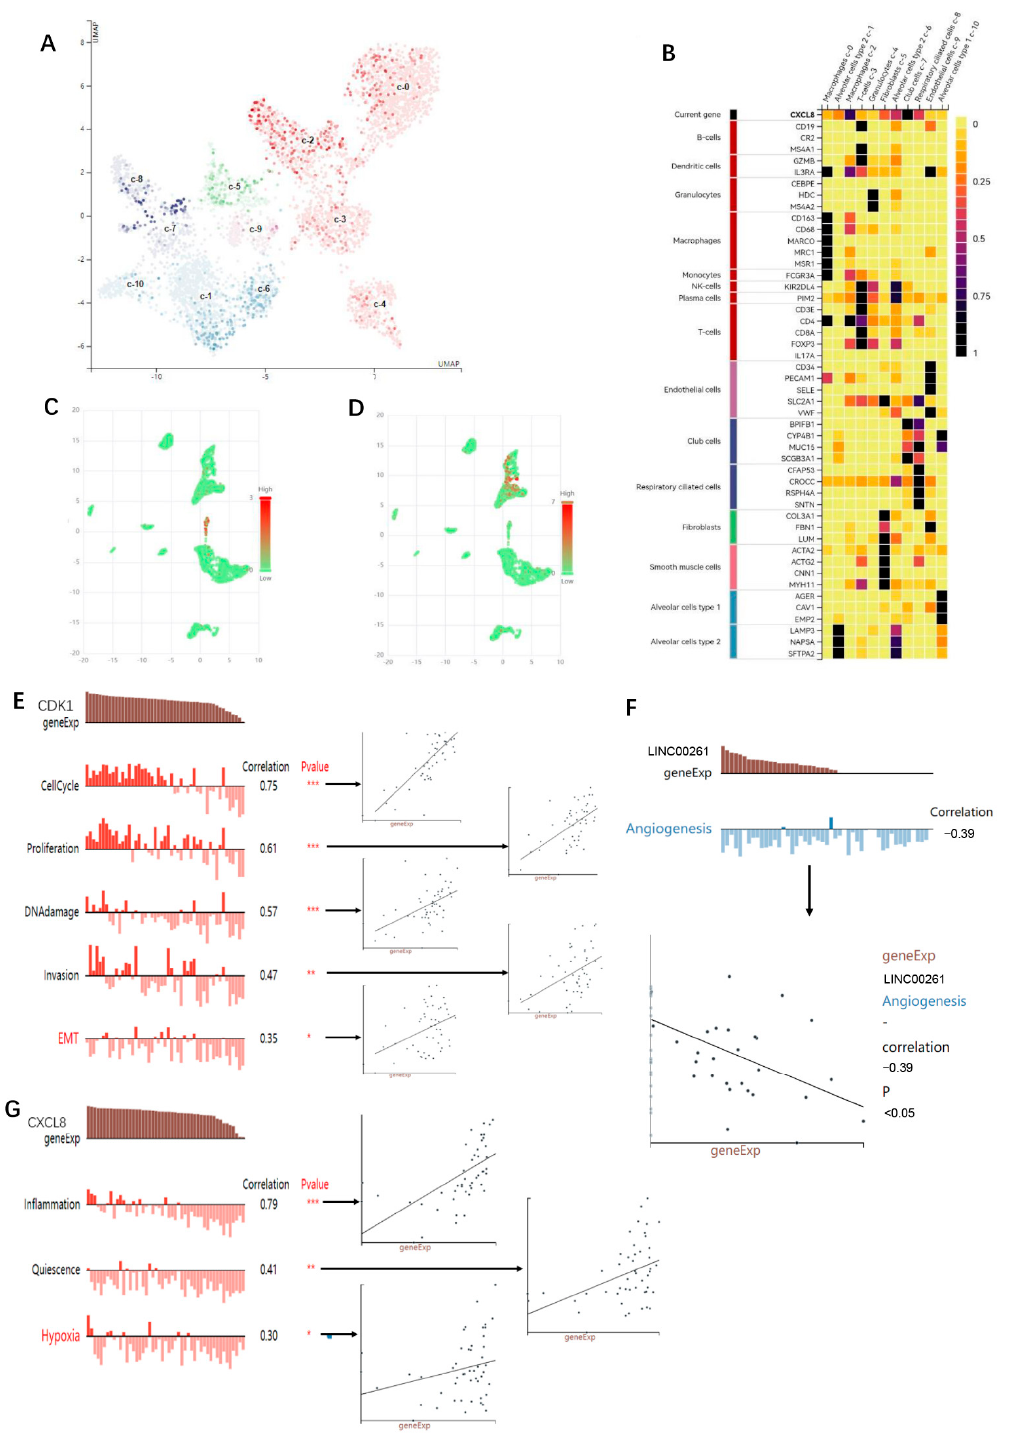
Figure 9. Results of single cell analysis. ( A ) CXCL8 expression in normal lung tissues. ( B ) Cell maker of the cells in ( A ). The analysis of ( A , B ) are from HPA database. ( C ) Single cell analysis of CDK1 expression in lung cancer tumor tissues. ( D ) Single cell analysis of CXCL8 expression in lung cancer tumor tissues. The analysis of ( C , D ) are from Cancer Single-cell Expression Map database. ( E ) Functional states analysis of CDK. ( F ) Functional states analysis of LINC00261. ( G ) Functional states analysis of CXCL8. The analysis of ( E – G ) are from CANCERSEA database. Significance markers: * p < 0.05; ** p <0.01; *** p <